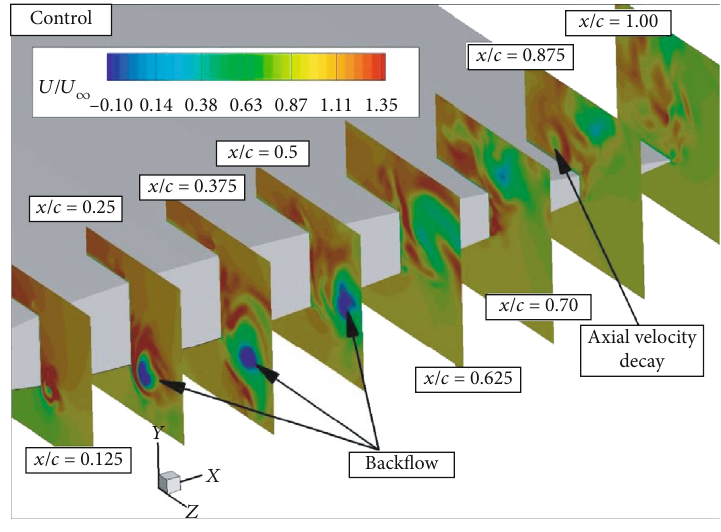
Figure 18: The axial velocity distribution under normal blowing.